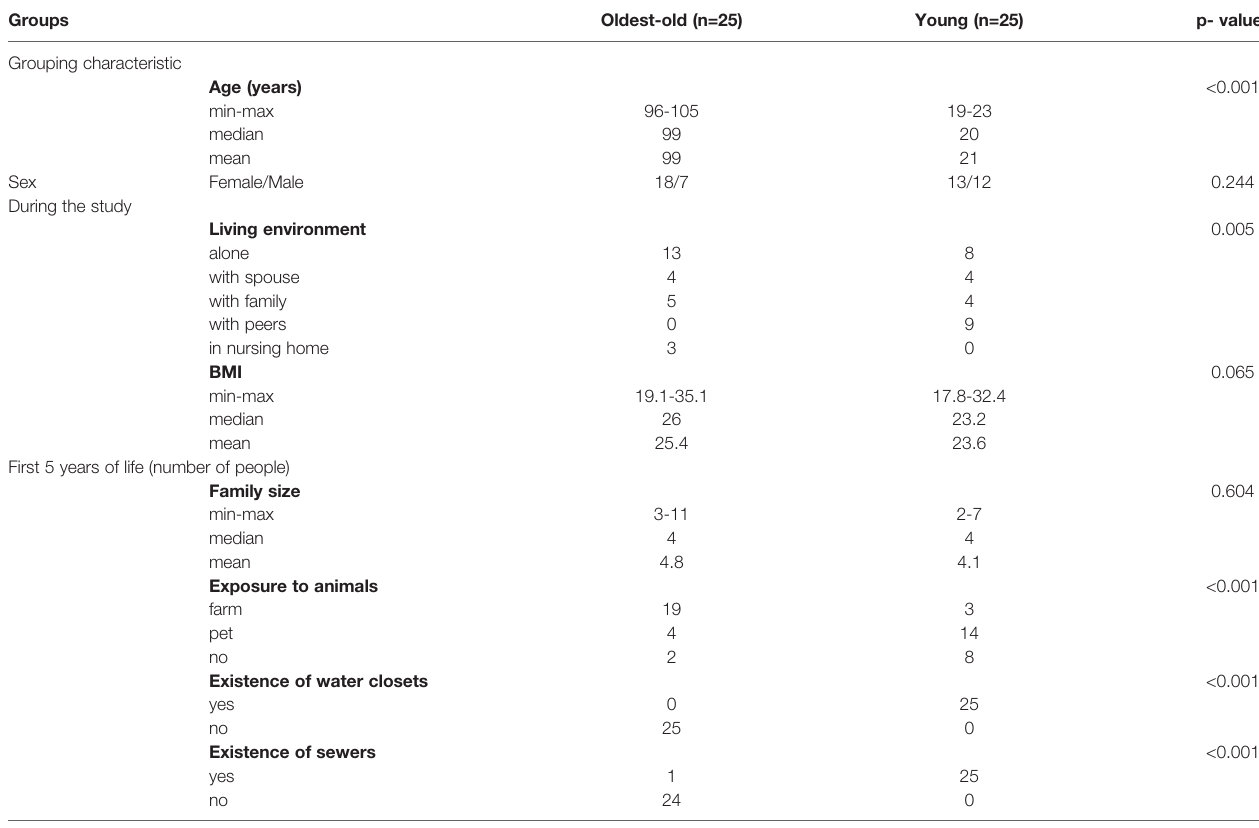
TABLE 1 | Basic characteristics and living environment of the study subjects.